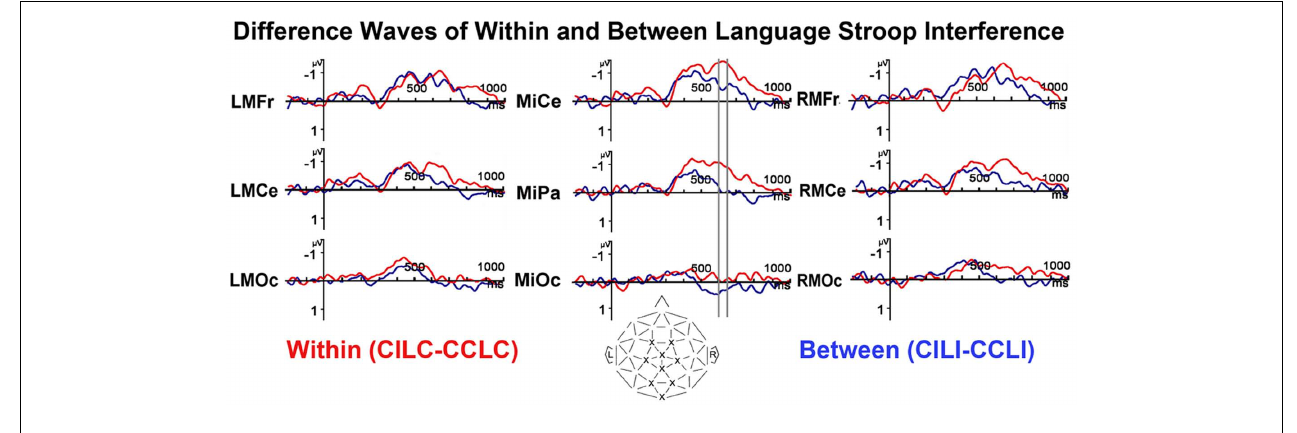
FIGURE 7 | Difference ERPs (color incongruence minus congruent) for within and between language trials separately. Sliding window analysis in 50ms increments revealed that through 600ms both between and within language Stroop effects were significant and no